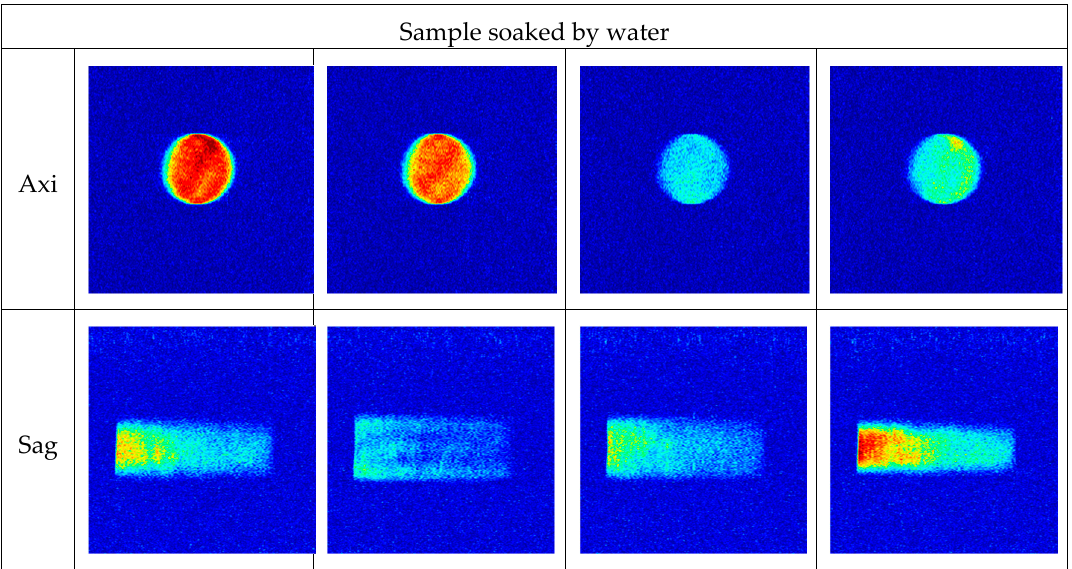
Figure 9. NMR imaging of samples soaked by different drilling fluids.